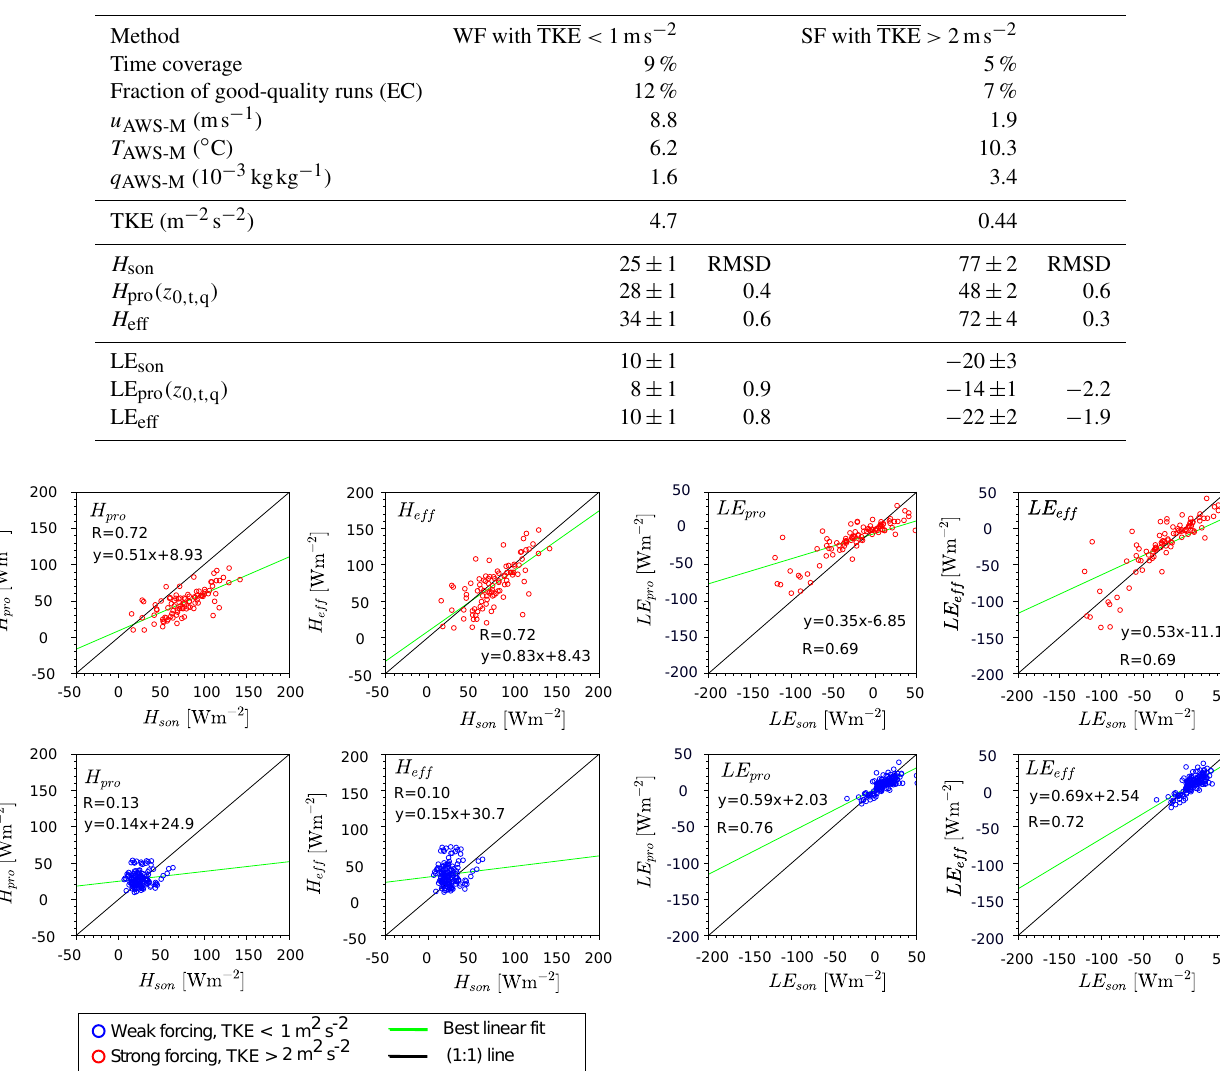
Table 3. Characteristics of the two field campaigns in terms of turbulent fluxes measured with the eddy covariance (EC; sonic) and modelled with the profile methods with different roughness parameters (pro, eff). Correlation, coefficients as well as normalised root mean square deviations (RMSD) from the least-squares fit between each profile method fluxes and sonic fluxes are presented.